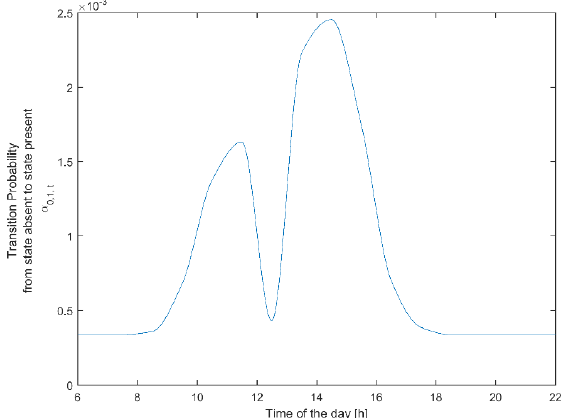
Figure 1. Non-homogeneous transition probability from the absent state to the present state (a 01, t = 𝑃[𝑞 𝑡+1 = 1|𝑞 𝑡 = 0] ) as a function of time of day, t.